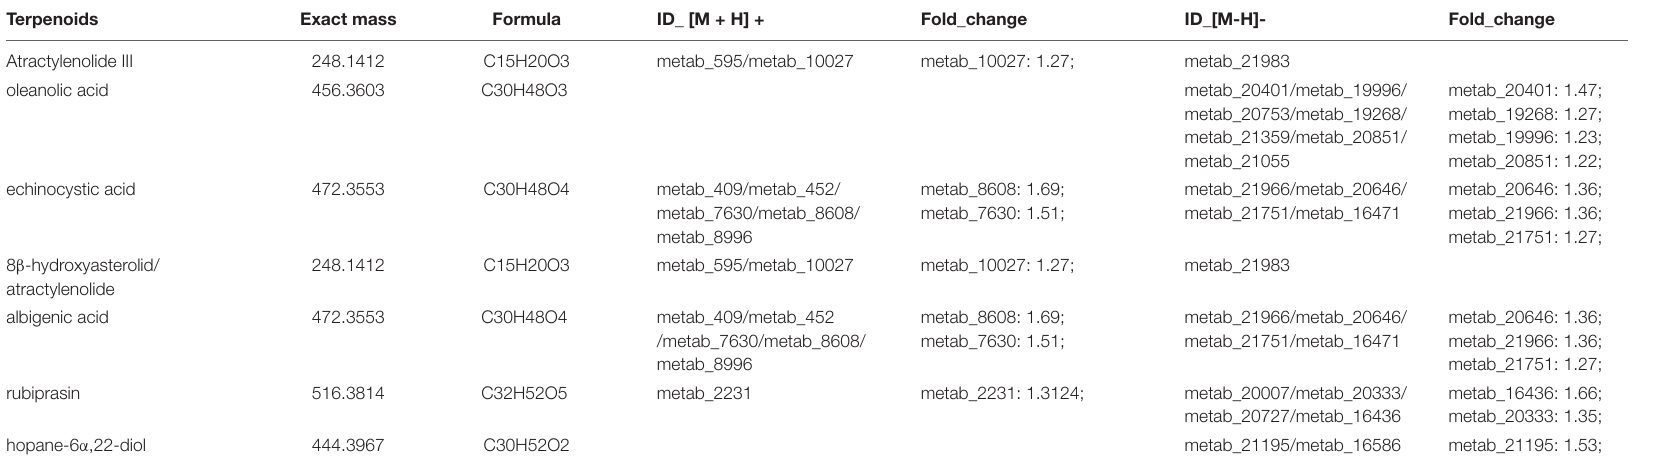
TABLE 5 | Differentially expressed metabolites (DEMs) annotated as terpenoids.